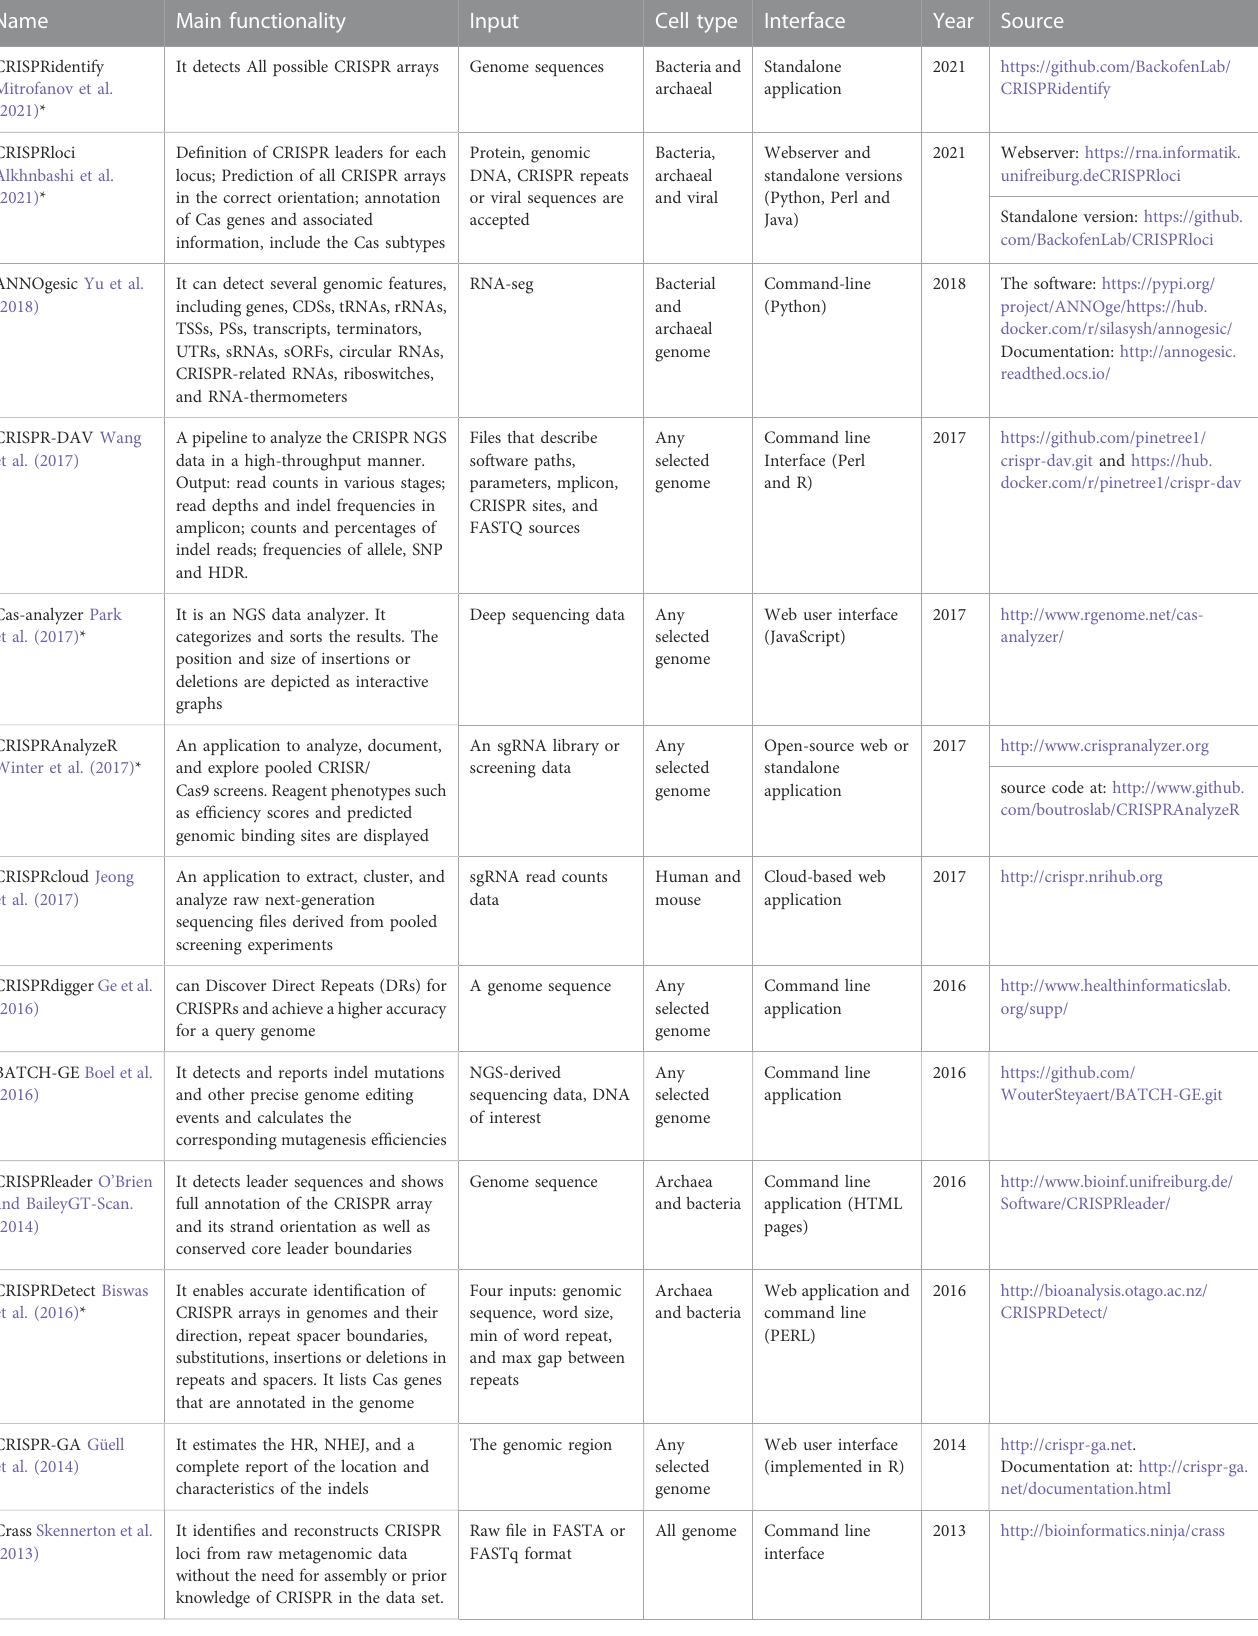
TABLE 1 Tools and software packages related to CRISPR